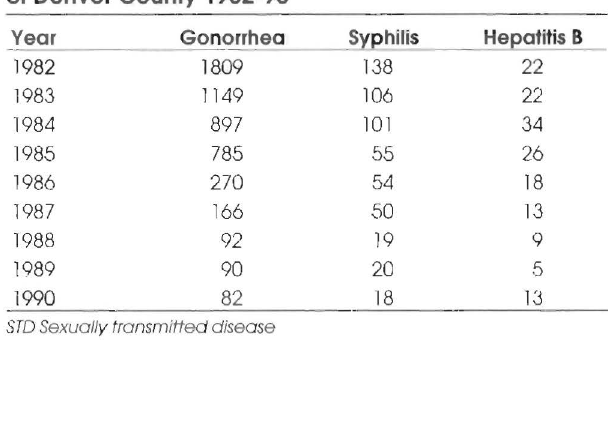
Numbers of new cases of gonorrhea and syphilis